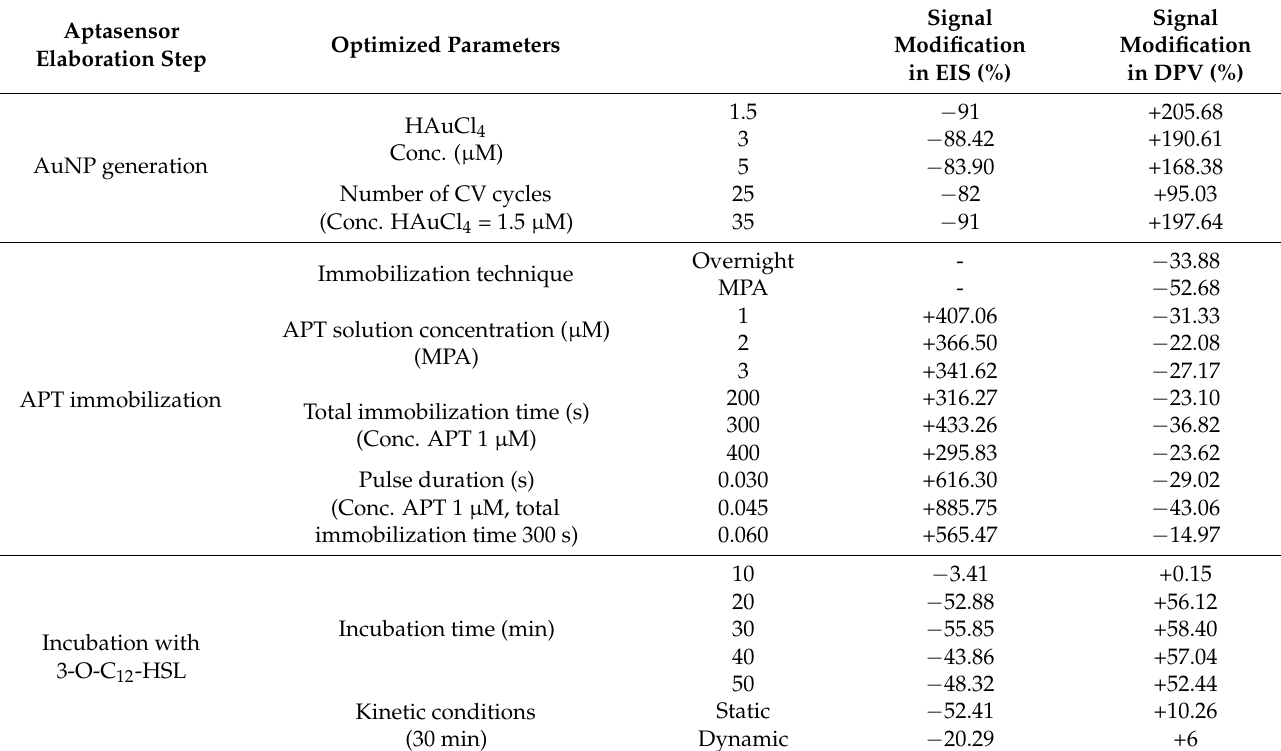
Table 2. Signal modification in EIS and DPV after each optimized